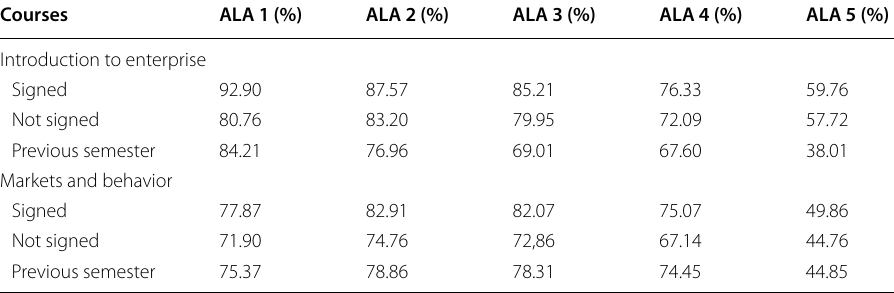
Table 7 Performance for each ALA